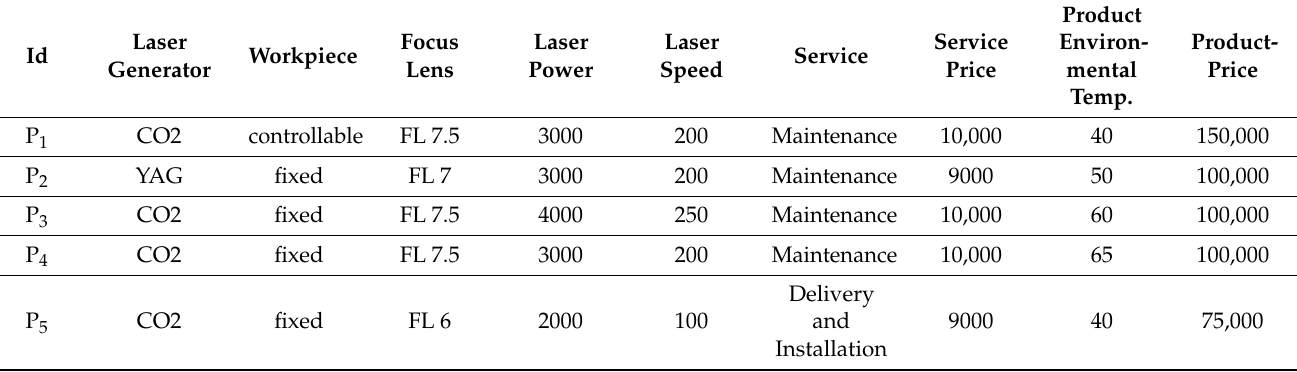
Table 9. Examples of previously customized PSSs (C PSS ).